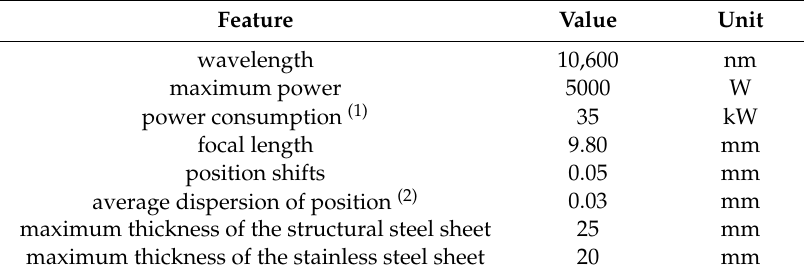
Figure 1. Schematic of the experimental setup used for tests. Table 3. Main features of the adopted laser system.